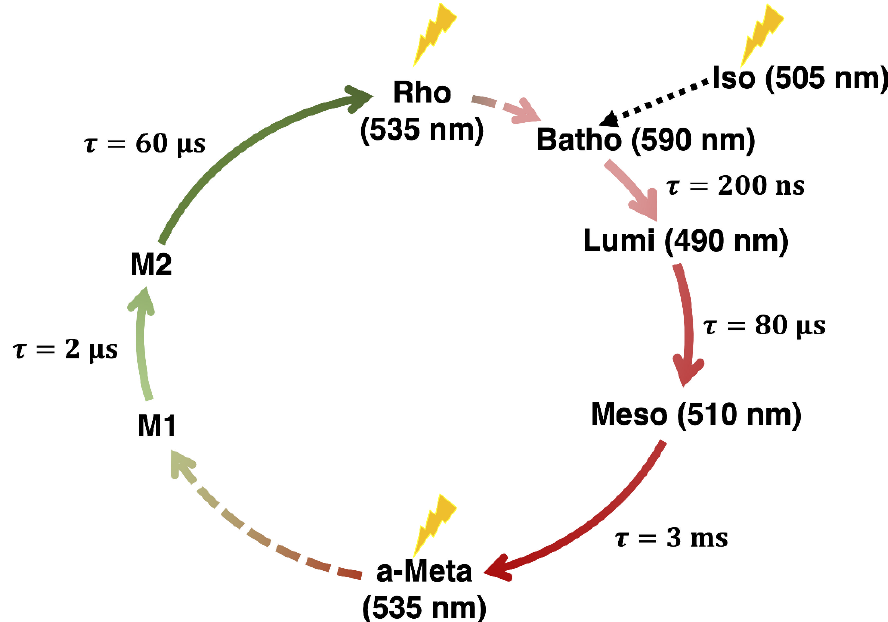
Figure 2. Photocycle of JSR1 showing the conversion between the Rho (11- cis ) and a-Meta (all- trans ) states, as well as conversion of Iso (9- cis ) to the Batho intermediate.